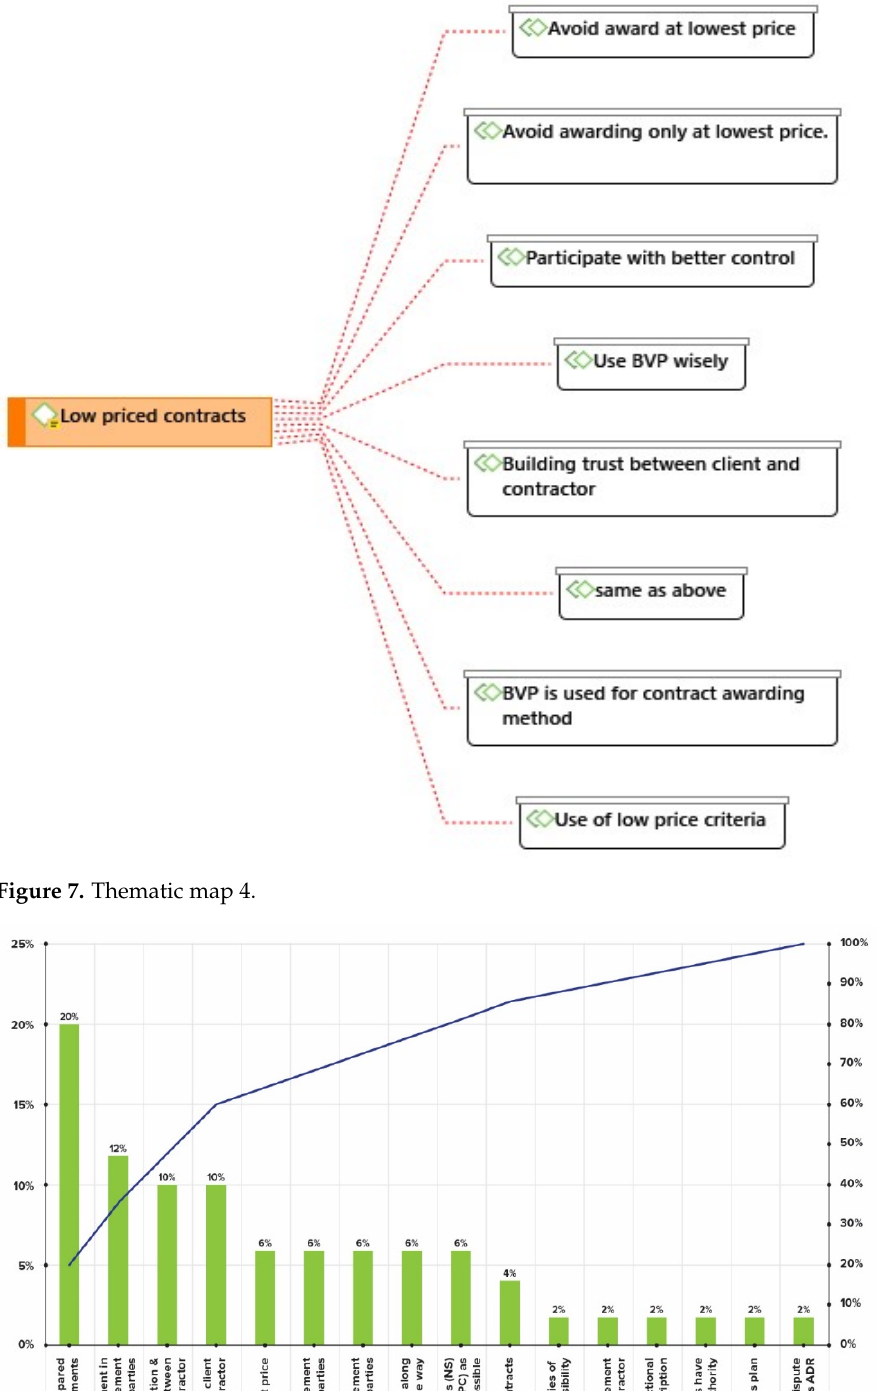
Figure 9. Pareto diagram showing disputes prevention techniques related to final settlement—pay- ment related.